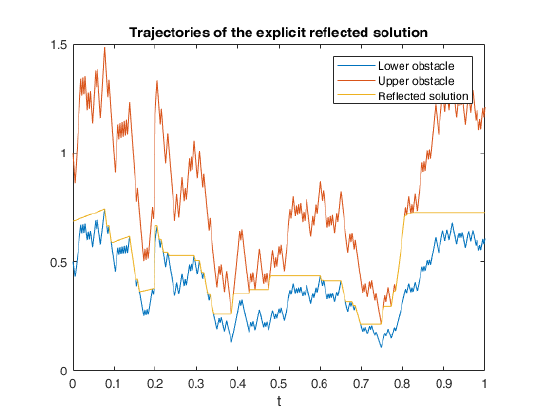
Figure 8. One path of the Brownian motion.